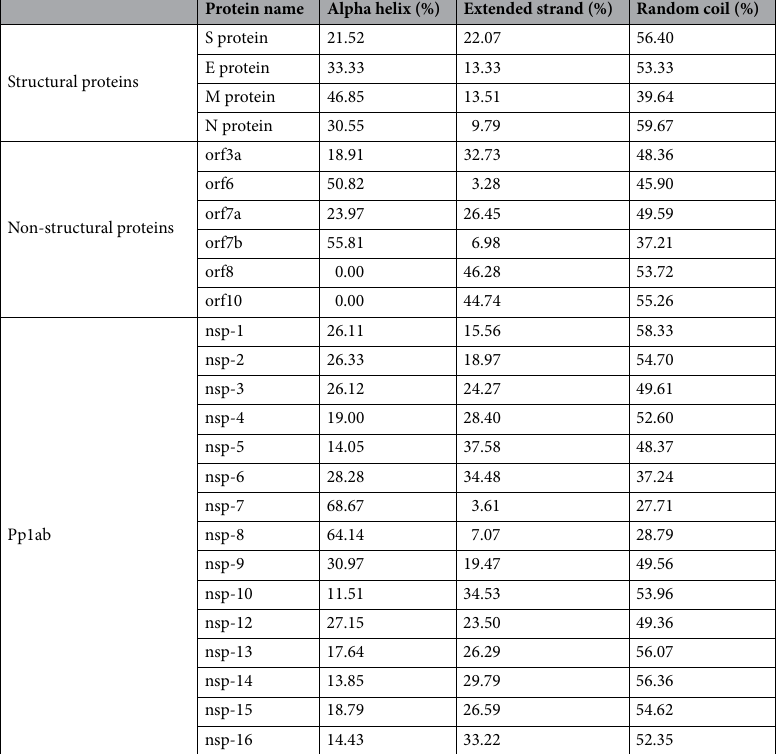
Table 2. Secondary structures results predicted by GOR